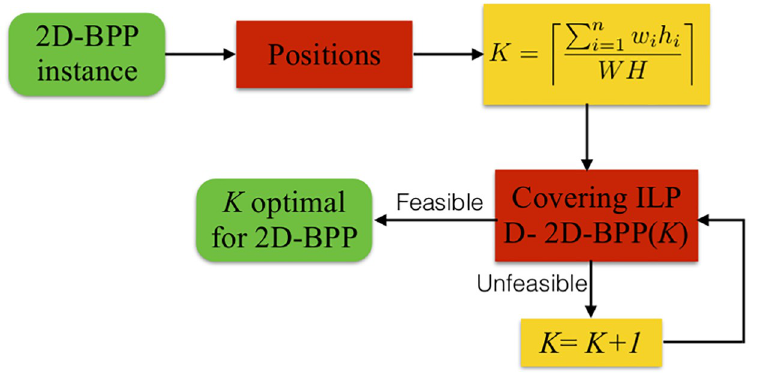
Fig 2. Scheme of the P&C. The two-step methodology to solve the